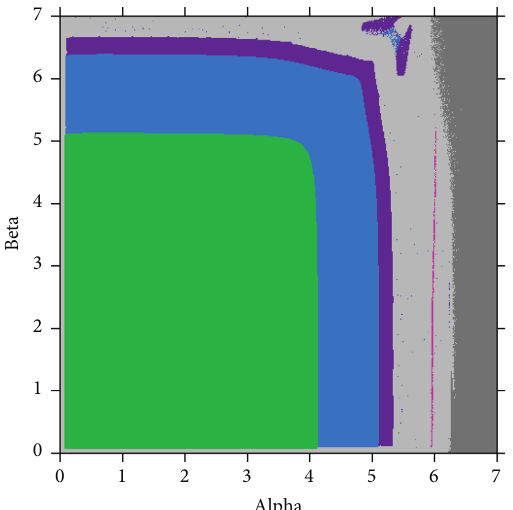
Figure 2: The parameter basin with respect to α and β